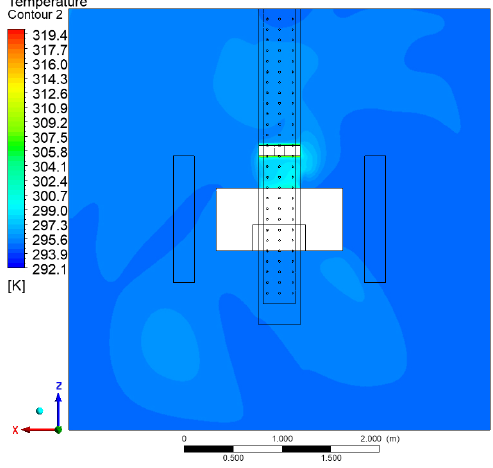
Figure 26. The temperature distribution of the Y = 0.6 m section.